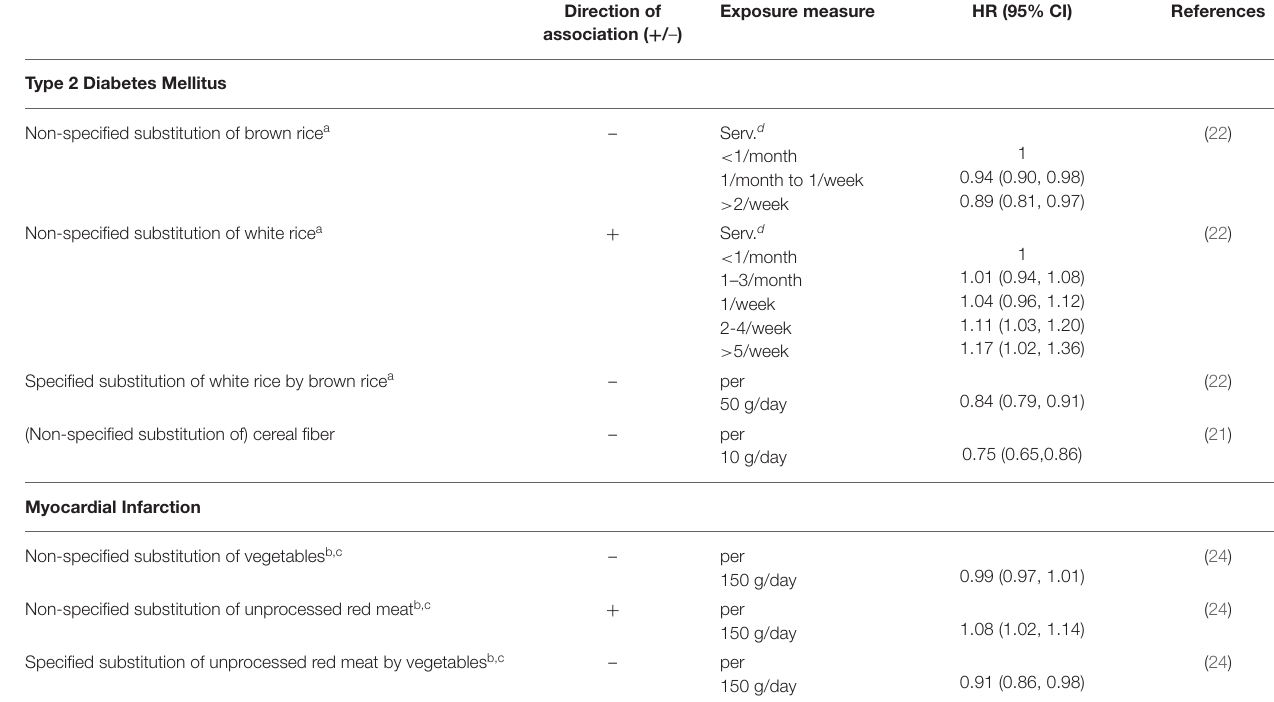
TABLE 1 | Identified association measures at different food